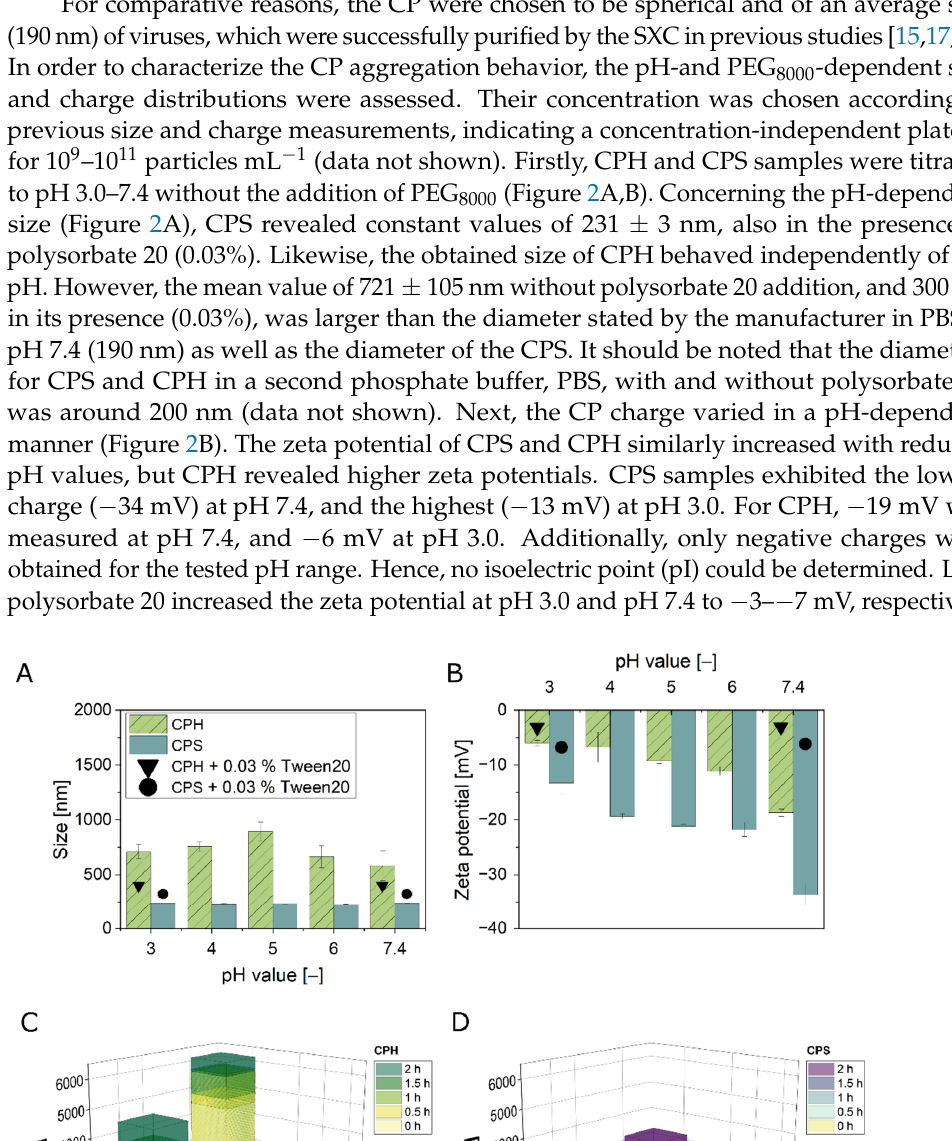
Figure 2. Polystyrene particle characterization. The functionalized polystyrene particles, sulfated (CPS) and hydroxylated (CPH), were characterized prior to the chromatographic experiments. ( A , B ) show the size distribution and electrophoretic mobility, expressed as zeta potential, of CPH (green, striped) and CPS (blue) at varying pH (and 0% PEG 8000 ). Additionally, the particles were supplemented with 0.03% polysorbate 20 (Tween 20) (black triangle and circle, respectively). Vis- ualized are the measurements directly after the sample preparation at t = 0 min. The data shows